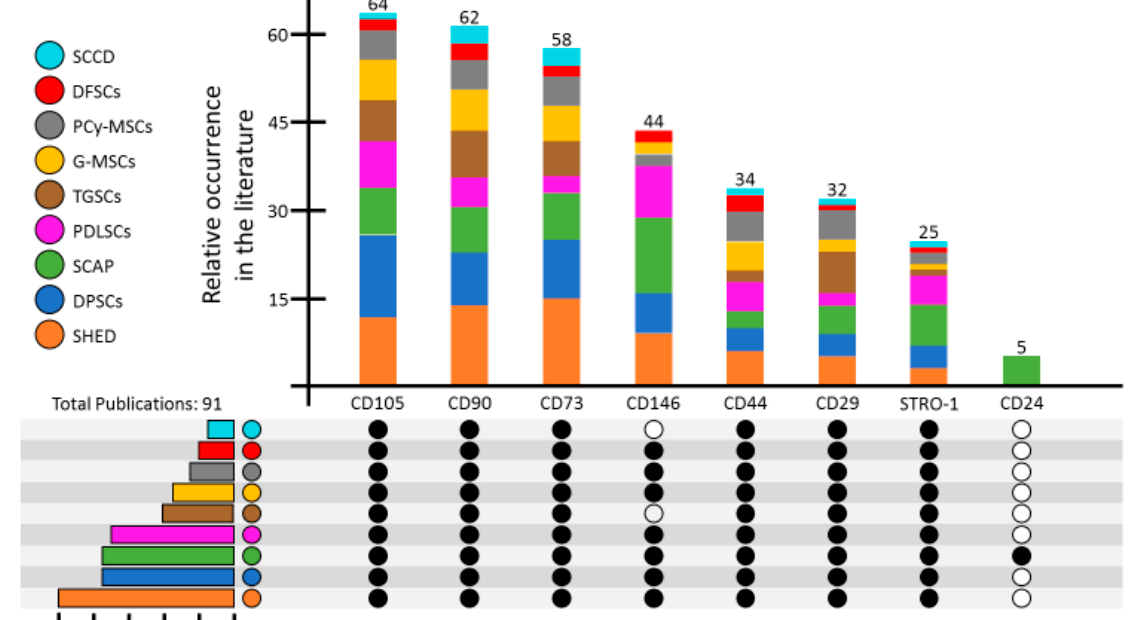
Figure 2. Marker expression profile of the different stem cells isolated from dental tissues. For this analysis, 91 publications were analyzed. The publications were chosen by their content focusing on each dental stem cell type and their isolation and characterization. We analyzed 20 SHED publications, 15 DPCs and SCAP publications, 14 PDLSCs publications, 7 G-MSCs publications, 4 DFSCs publications, and 3 SCCD publications. The black circles indicate that the marker was described to be expressed in the literature, while the white circles indicate that the expression of the marker has not been described in the literature yet.